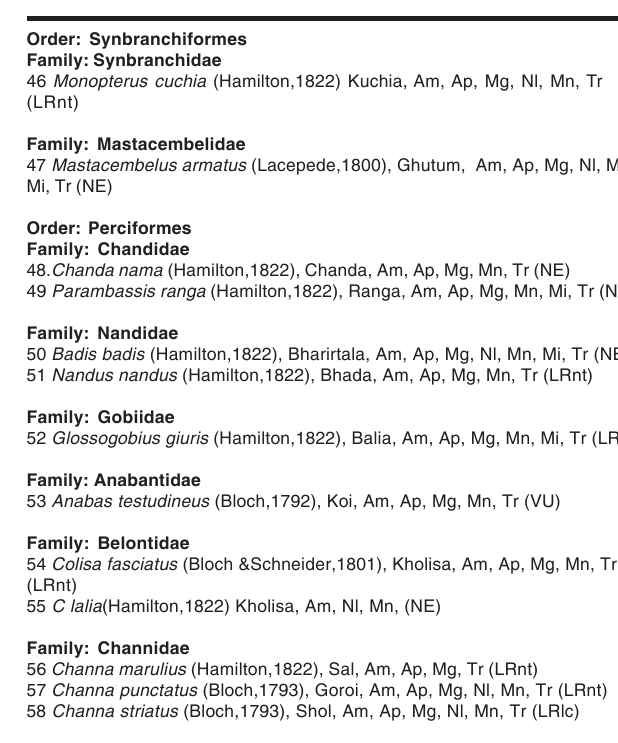
Order: Synbranchiformes Family: Synbranchidae